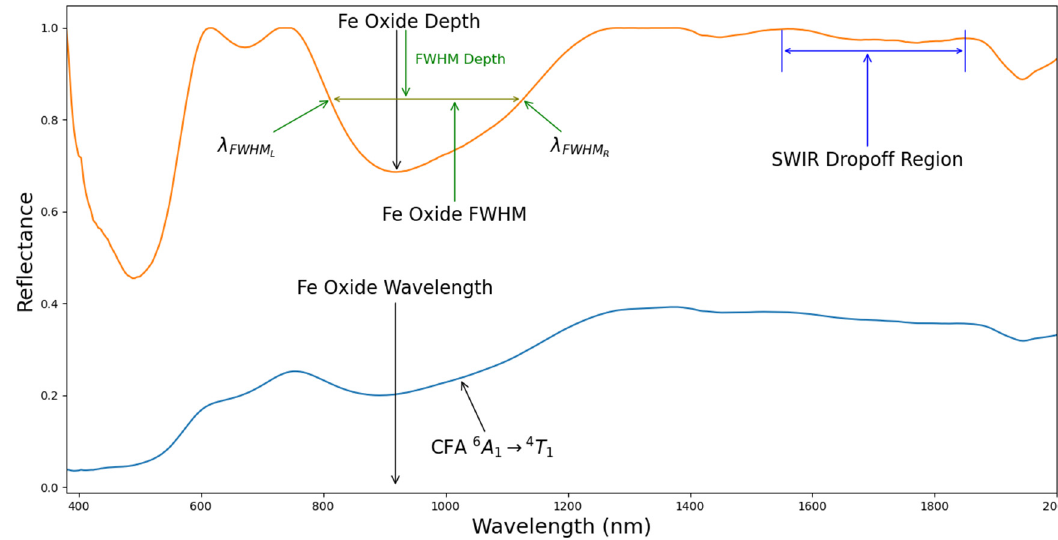
Figure 4. The blue reflectance spectrum is a goethite sample showing the broad 6 A 1 → 4 T 1 crystal absorption feature. The upper spectrum in orange is a hull corrected spectrum. In this case the hull has been corrected across the full spectral range for illustrative purposes. The hull corrected 6 A 1 → 4 T feature is used to define the point at which the deepest absorption value occurs and defines the Fe Oxide Wavelength, Fe Oxide FWHM, and Fe Oxide Depth spectral metrics. The wavelength region between 1550 nm and 1850 nm is the region where a local hull correction is performed, and the maximum depth recorded as the SWIR Drop-off metric.